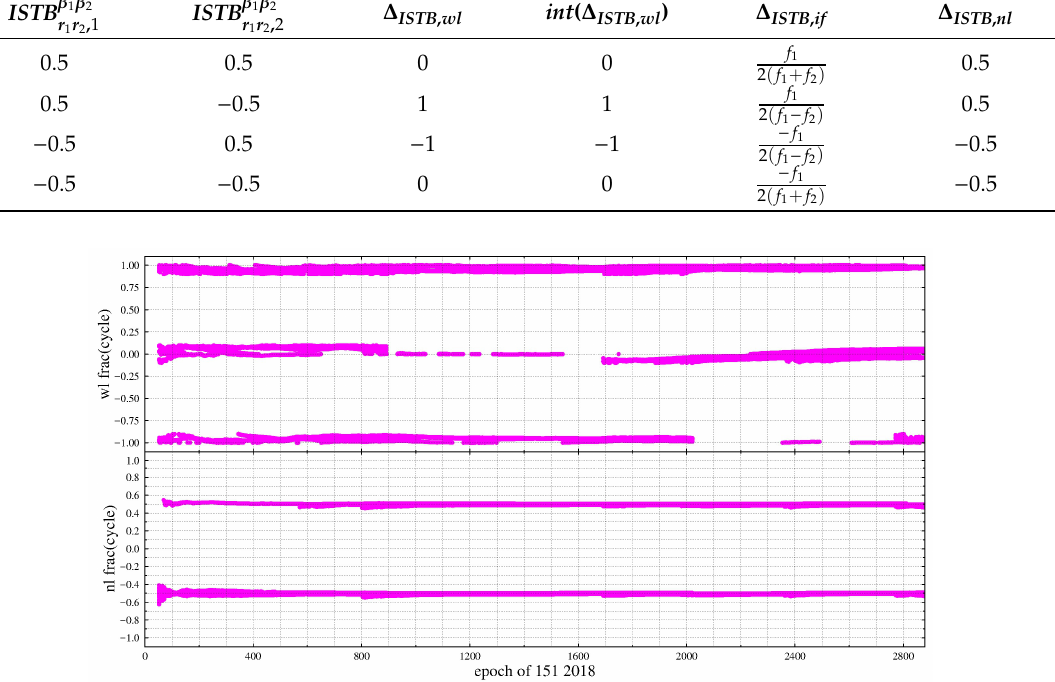
Figure 2. The fractional parts of WL and NL DD ambiguities for GEO and non-GEO Satellites at zero-baseline CUCC-CUTC.